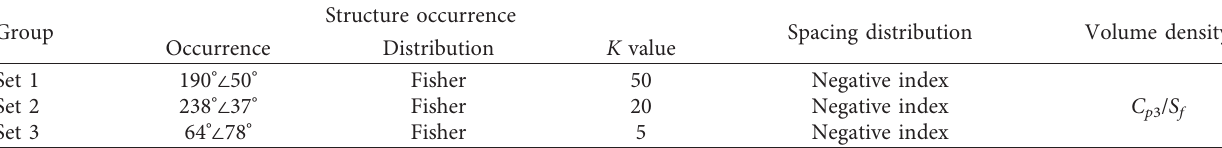
Table 2: Parameters of 3D fracture